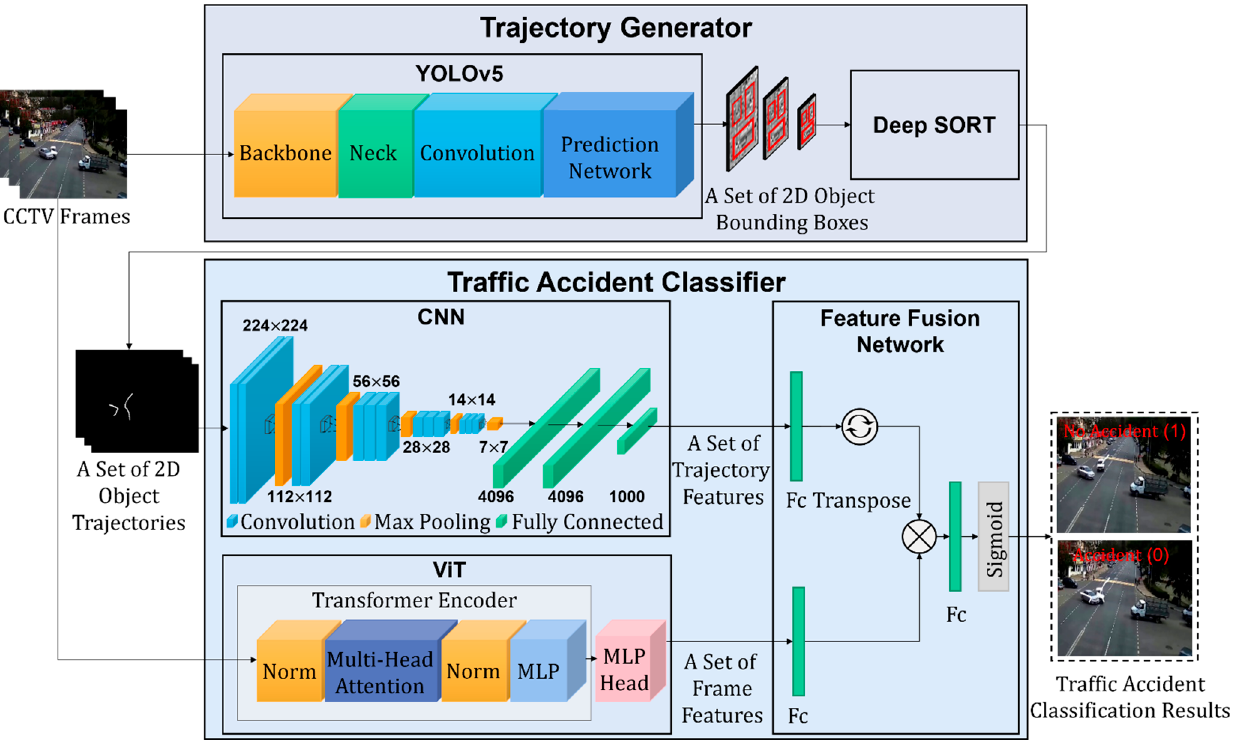
Figure 2. Model of the proposed hybrid traffic accident classification method.